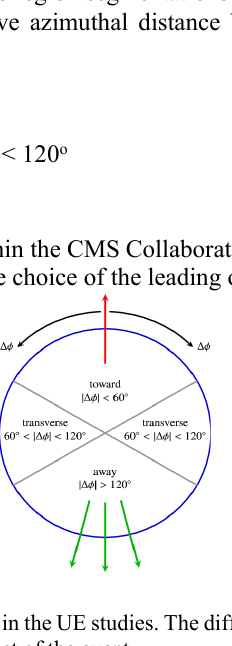
Fig. 5. Differential cross section for exclusive in the rapidity interval 1.2 < | 𝑠𝑠 |